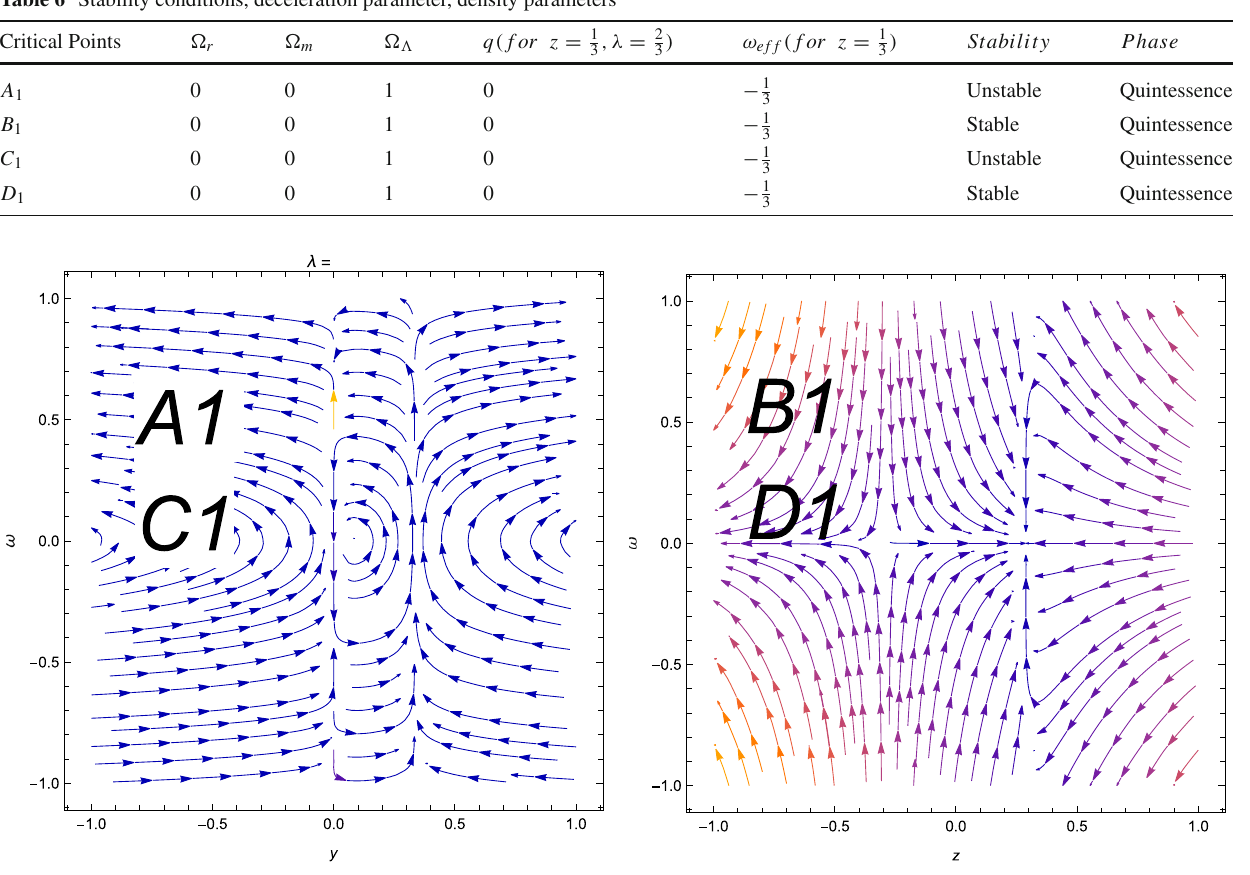
Fig. 3 Phase portrait for mixed power law model. Here we plot the graph between z and w and y and